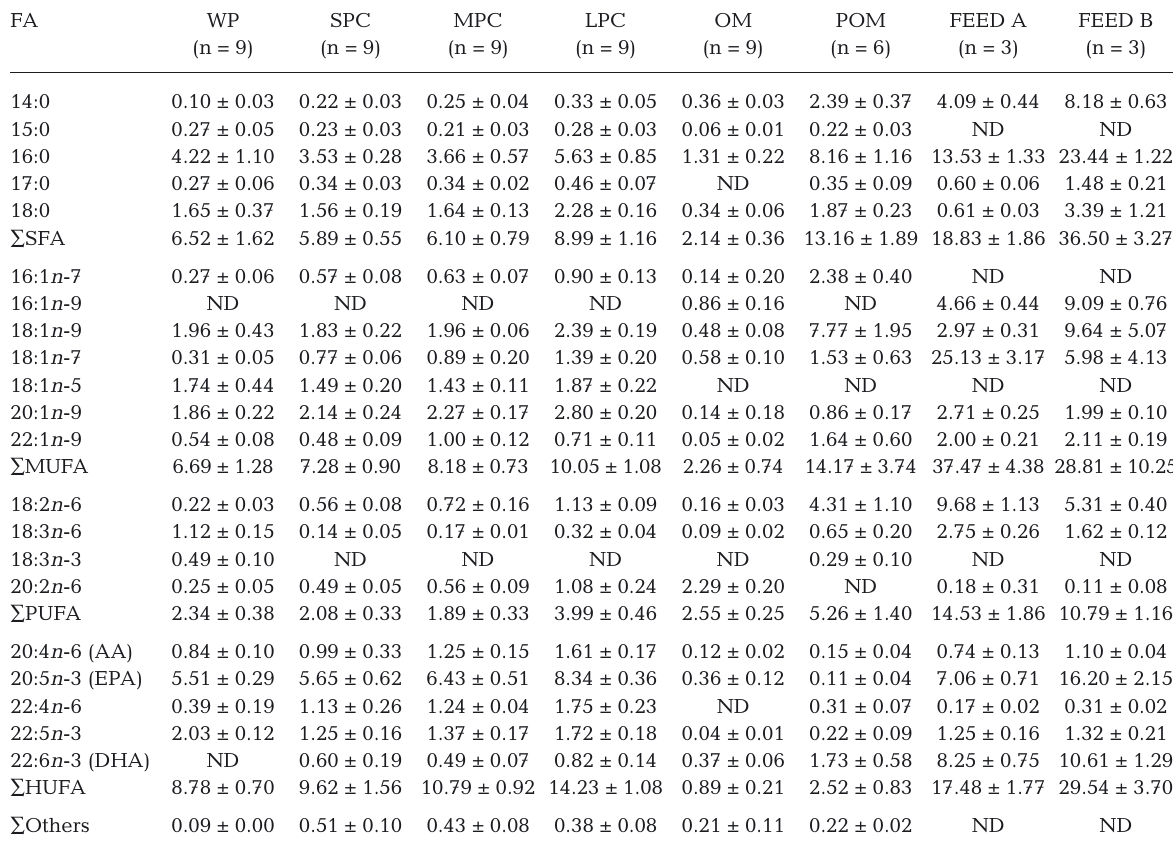
(SFA), WP presented 6.52 ± 1.62 µg g −1 DW, while LPC displayed 8.99 ± 1.16 µg g −1 DW, with the most repre- sentative SFA being palmitic acid (16:0) (4.22 ± 1.10 and 5.63 ± 0.85 µg g −1 DW for WP and LPC, respec- tively). The identification and quantification of the FA profiles of FEED A and B, POM and OM revealed that the most representative FA in each of these samples was: (MUFA) vaccenic acid (18:1 n -7) (25.13 ± 3.17 µg g −1 DW) for FEED A; (SFA) palmitic acid (16:0) for FEED B (23.44 ± 1.22 µg g −1 DW) and POM (8.16 ± 1.16 µg g −1 DW), and (PUFA) eicosadi enoic acid SIMPER analysis showed that the FA profiles of WP and LPC displayed an average dissimilarity of 20.2%, with more than 50% of that dissimilarity being